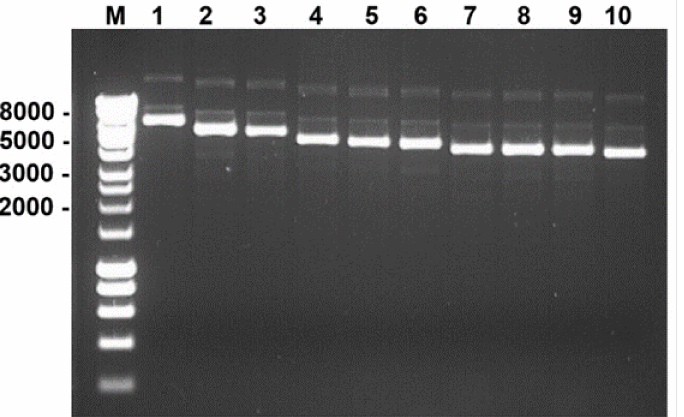
Figure 2. Agarose gel electrophoresis analysis of the pGEX-4T-2 plasmid clones containing the Figure S1. of BTV-1RG C7 (lanes 1–10). Lane M: DNA size marker labelled in